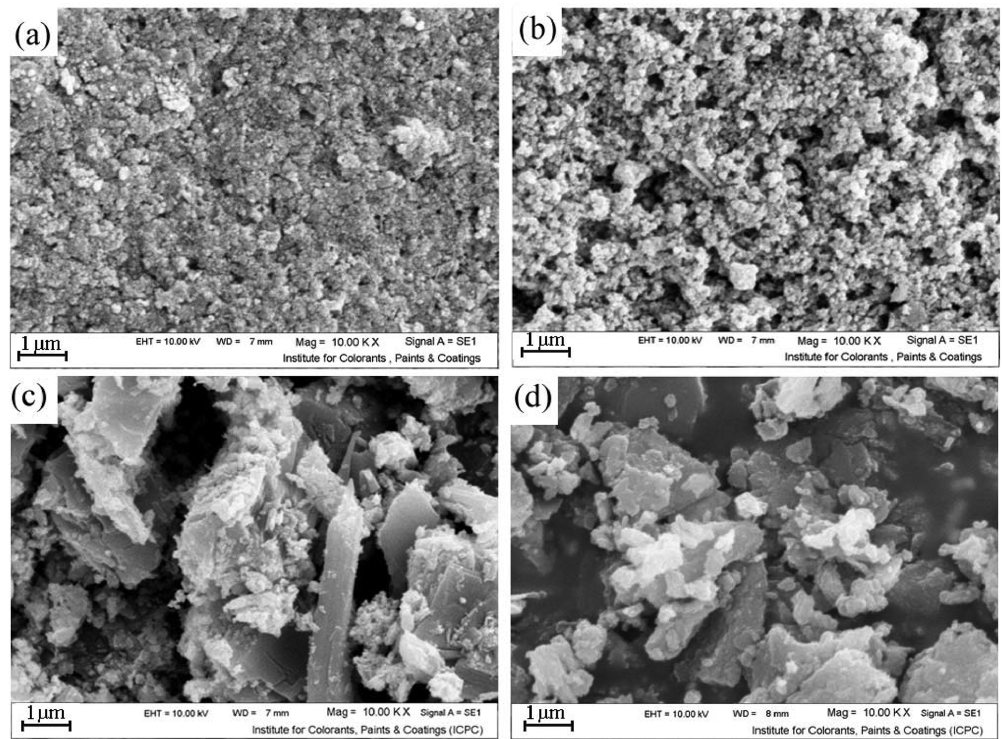
Figure 5: SEM images of MnOOH prepared with different sonication times: (a) 10 min (sample no. 8), (b) 20 min (sample no. 9),